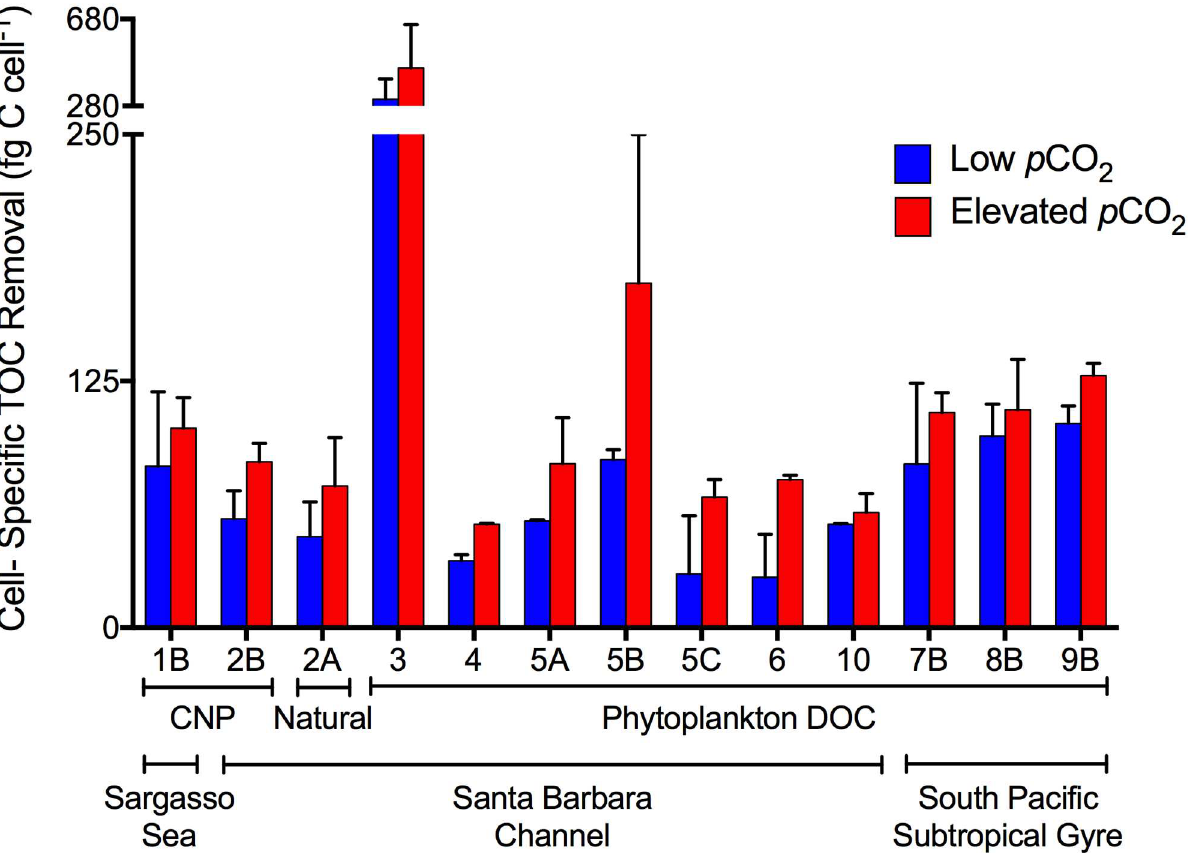
Fig 4. Cell-specific TOC removal. Mean ( ± SD) cell-specific TOC removalaveragedacross duplicateincubationsand calculatedas the change in TOC dividedby the concurrentchange in bacterioplankton abundance (BA) from the start of the incubationsto stationary phase. Numbers on X-axis label refer to the experiment number (Table 1). Colors denote cell-specific TOC removalat elevated p CO 2 (red) and low (ambient or pre-industrial) p CO 2 (blue). Only experiments where a changein TOC was resolvable are shown.